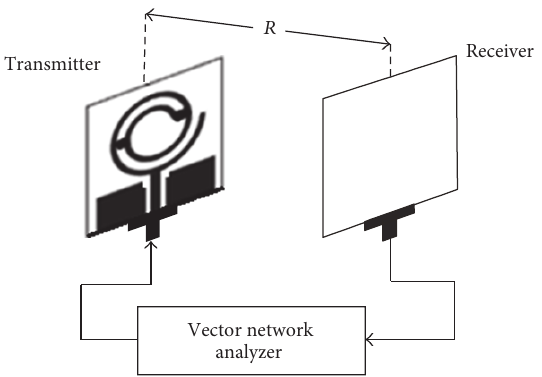
Figure 6: Measurement setup for time-domain